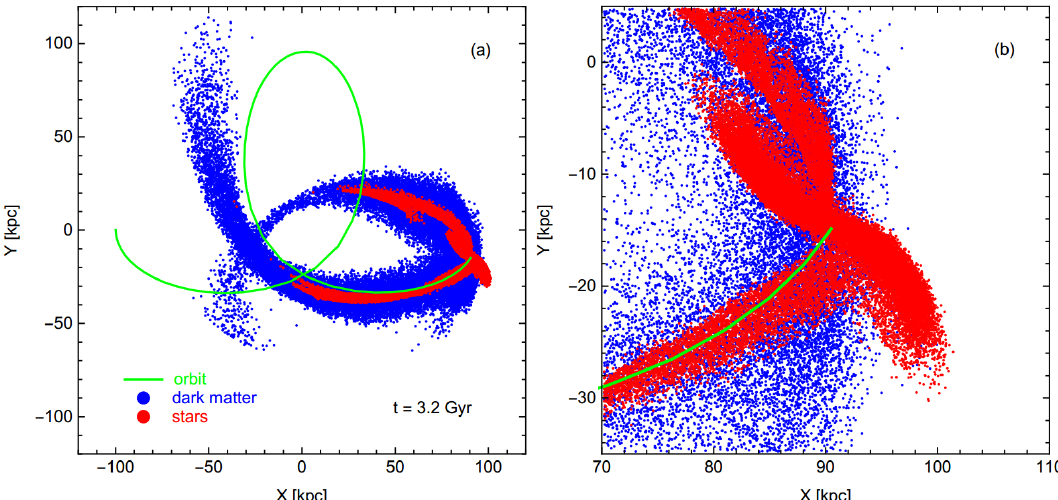
Figure 1. Overview of the simulation at the time of dwarf’s disruption, t = 3.2 Gyr, in projection onto the orbital plane. ( a ) The dark matter (blue) and stars (red) originating from the dwarf. The green line shows the orbit on which the dwarf evolved. The starting position was at ( X , Y , Z ) = ( − 100,0,0 ) kpc and the dwarf proceeded anti-clockwise; ( b ) Closer view of the disrupting dwarf at the same